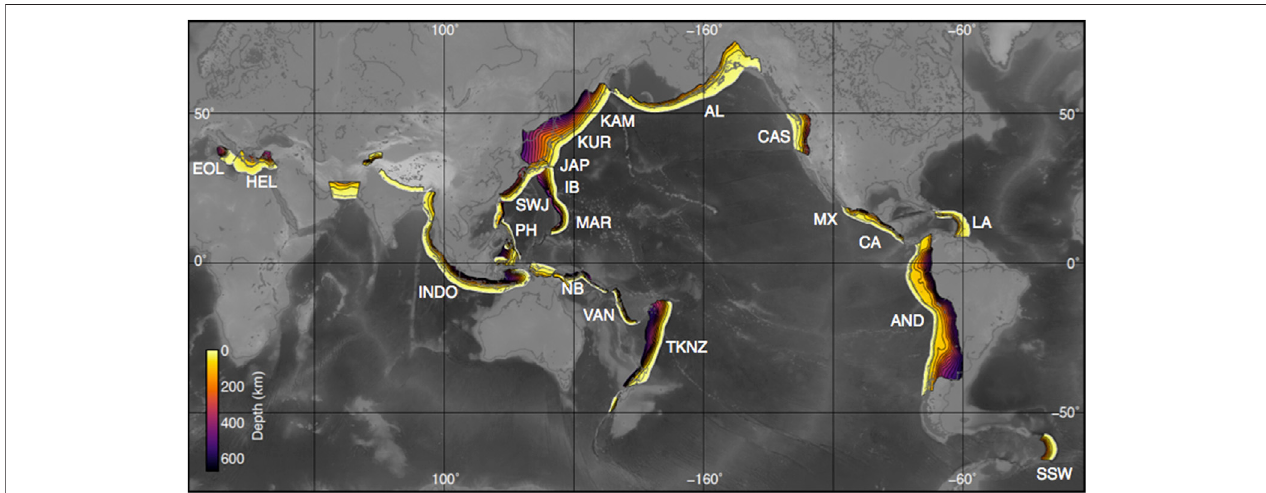
FIGURE1| Slab2imageshowingglobaldistributionofactivesubductionzones(Hayesetal.,2018).Contoursindicatedepthtoslabsurfaceandillustratevariations in slab geometry as de fi ned by distributions of SZ seismicity. Major subduction zones are labeled as follows: Cascades (CAS), Aleutian (AL), Kamchatka (KAM), Kurile (KUR), Japan (JAP), Mariana (MAR), Izu-Bonin (IB), SW Japan (SWJ), Philippine (PH), New Britain (NB), Vanuatu (VAN), Tonga-Kermadec-New Zealand (TKNZ), Andes (AND), Central America (CA), Mexico (MX), Lesser Antilles (LA), South Sandwich (SSW), Indonesia (INDO), Hellenic (HEL), and Eolian (AOL) arcs. Continent- continent collision zones near India are not